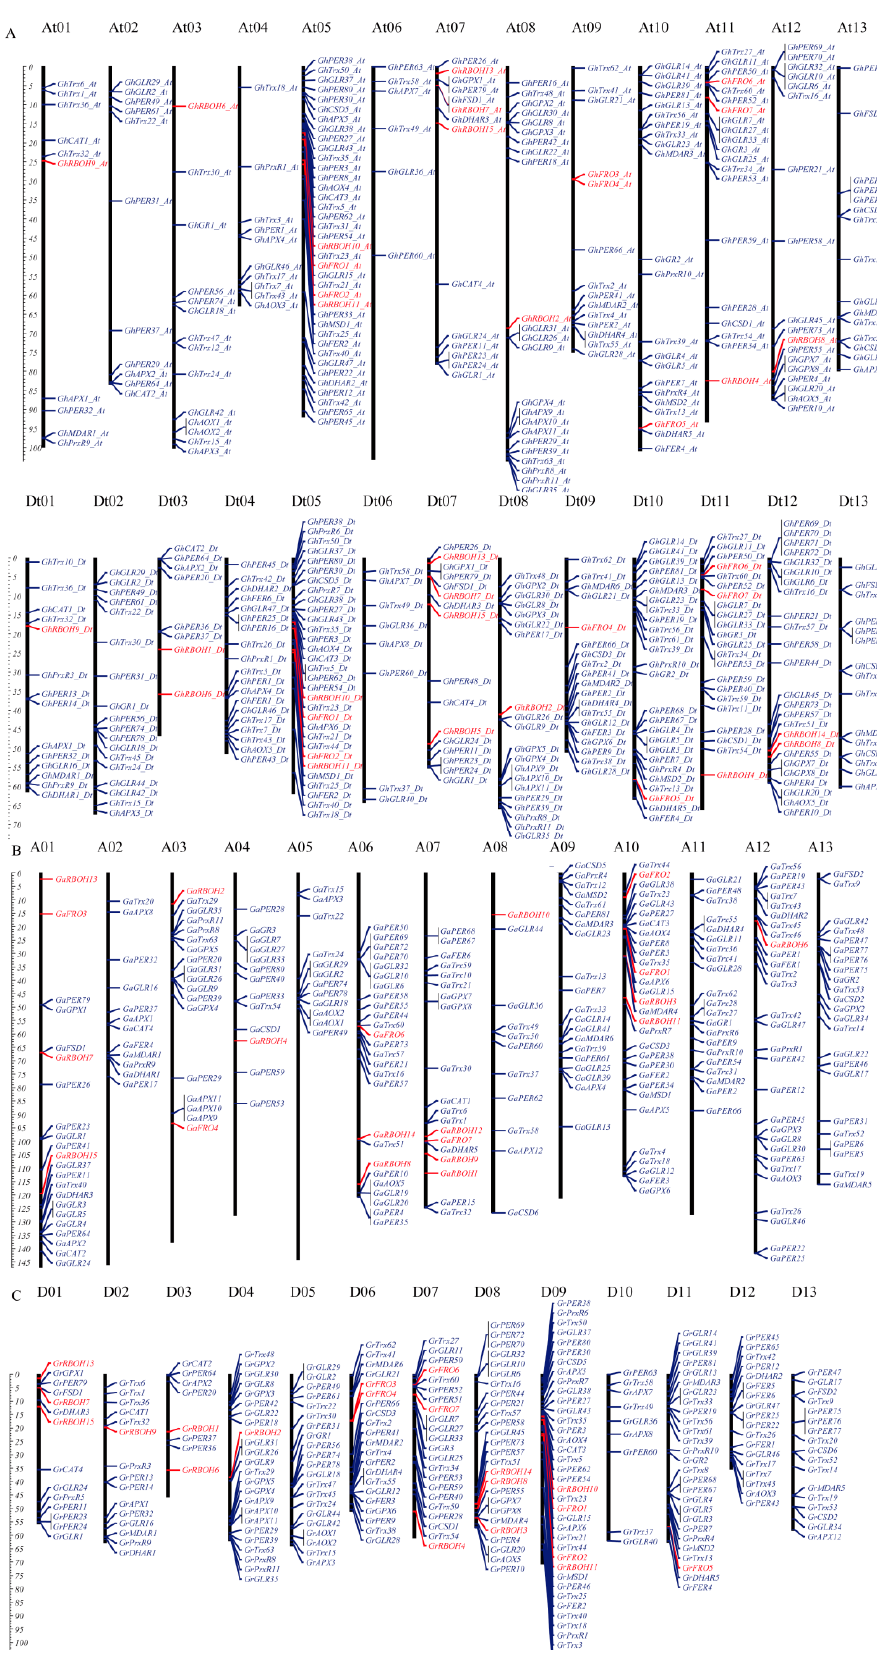
Figure 1. Distribution of reactive oxygen species (ROS) network genes in chromosomes of G. hirsutum , G. arboreum and G. raimondii . ( A ) Distribution of ROS network genes in chromosomes of G. arboreum . ( B ) Distribution of ROS network genes in chromosomes of raimondii . ( C ) Distribution of ROS network genes in chromosomes of G. hirsutum .